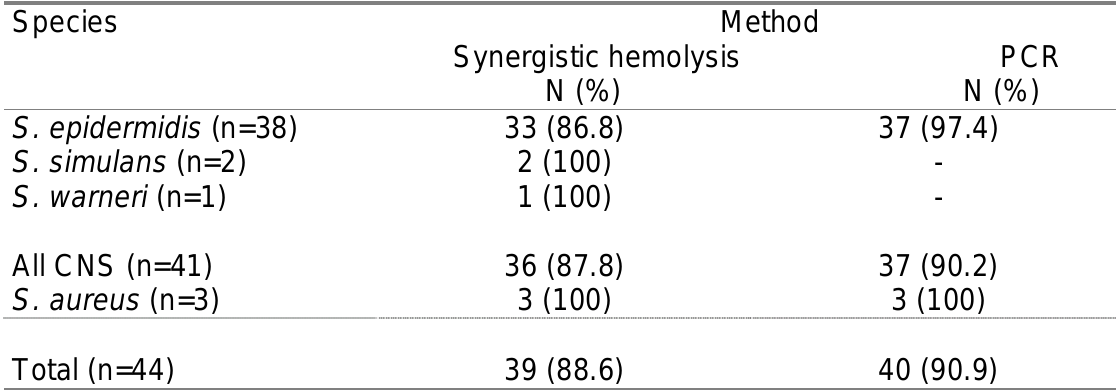
Table 3. Frequency of delta toxin-positive Staphylococcus strains according to detection method and